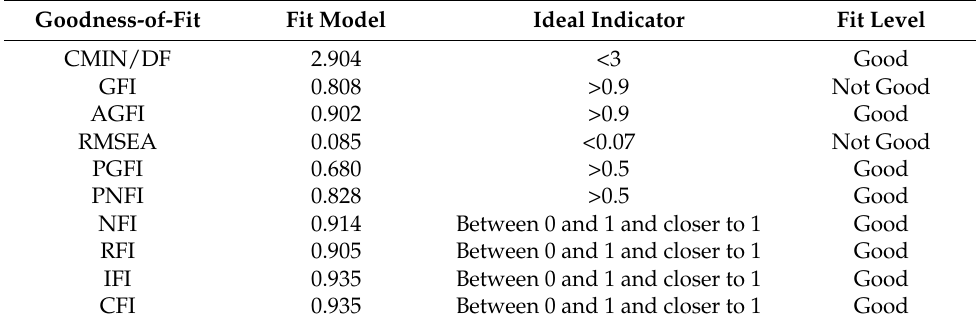
Table 9. Goodness-of-fit test for SEM of this